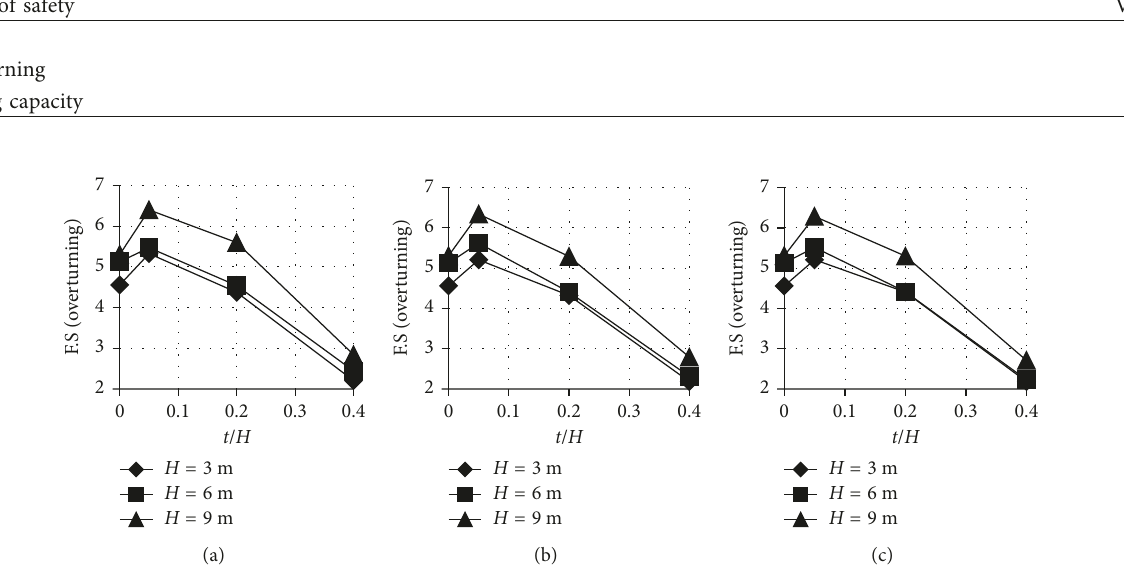
Figure 13: Influence of the geofoam thickness ratio on the overturning safety factor of yielding retaining walls. (a) EPS15. (b) EPS20. (c)